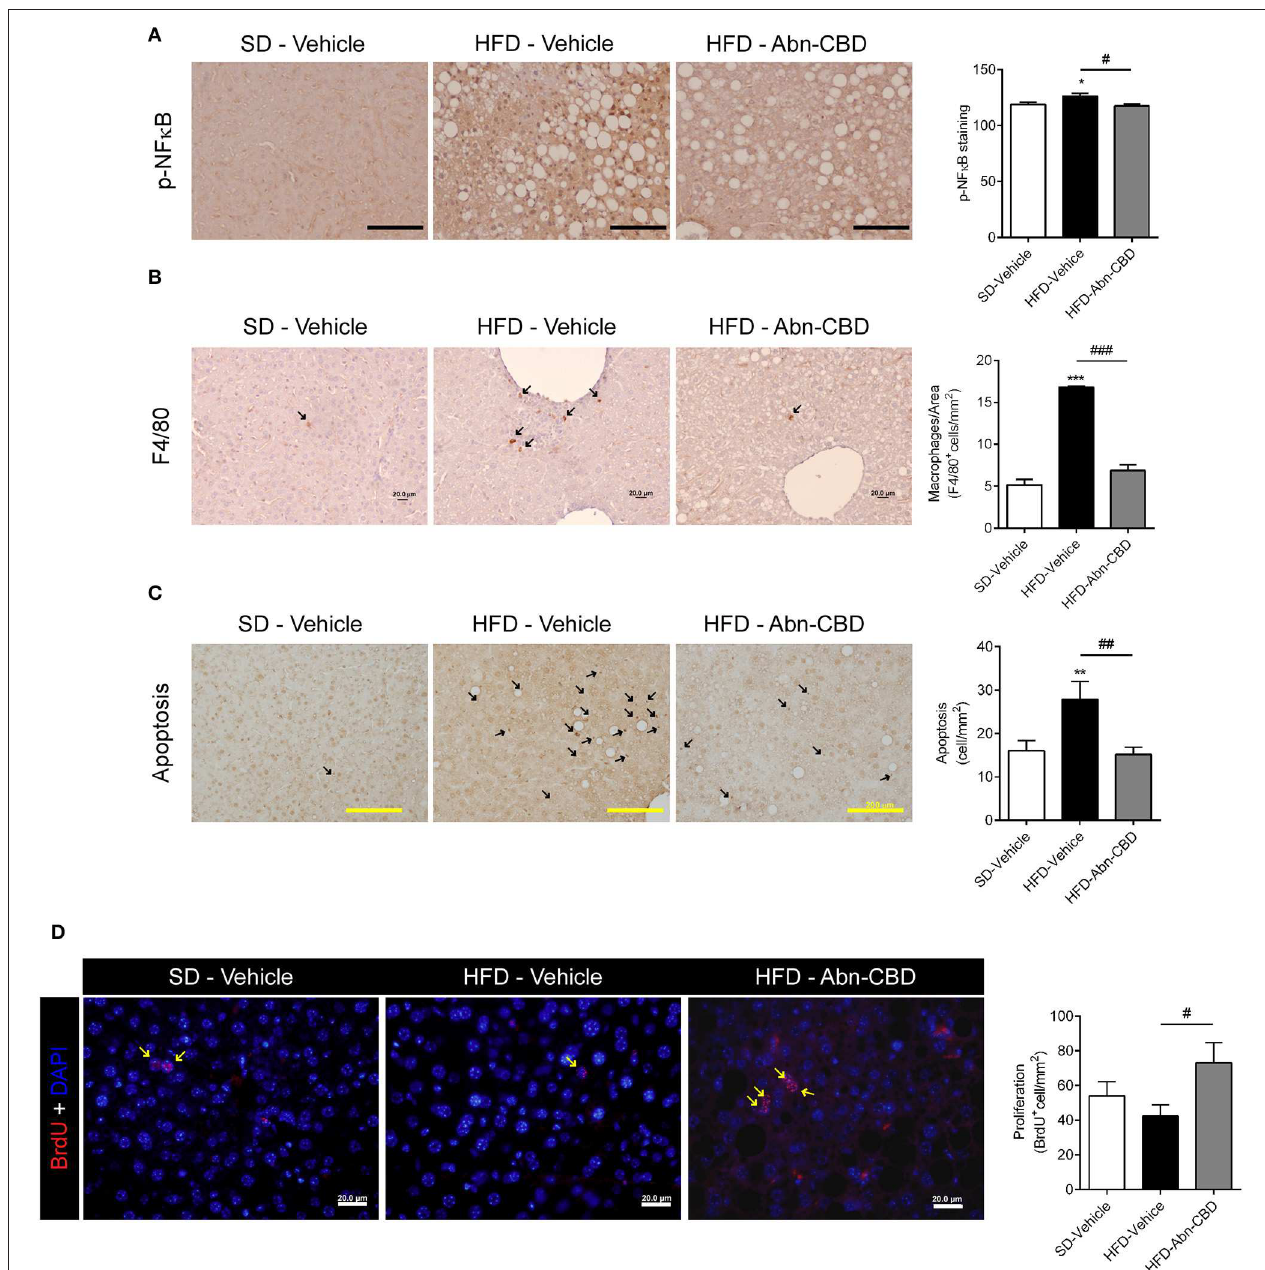
FIGURE 7 | Effect of Abn-CBD on hepatocyte viability and liver inflammation. (A) Representative photomicrographs and quantification of livers stained for the inflammatory marker p-NF κ B (A) , the macrophage marker F4/80 (B) and apoptotic cells (C) ; arrows indicate stained cells; scale bar is 100 µ m (A) , 20 µ m (B) , and 200 µ m (C) . (D) Representative photomicrographs and quantification of BrdU immunofluorescence (in red) in the liver, counterstained with DAPI (in blue). Arrows indicate proliferating cells. n = 7–8 SD-Vehicle, n = 5–8 HFD-Vehicle and n = 6–8 HFD-Abn-CBD. * p ≤ 0.05, ** p ≤ 0.01, and *** p ≤ 0.001 compared to SD-Vehicle; # p ≤ 0.05, ## p ≤ 0.01, and ### p ≤ 0.001 compared to